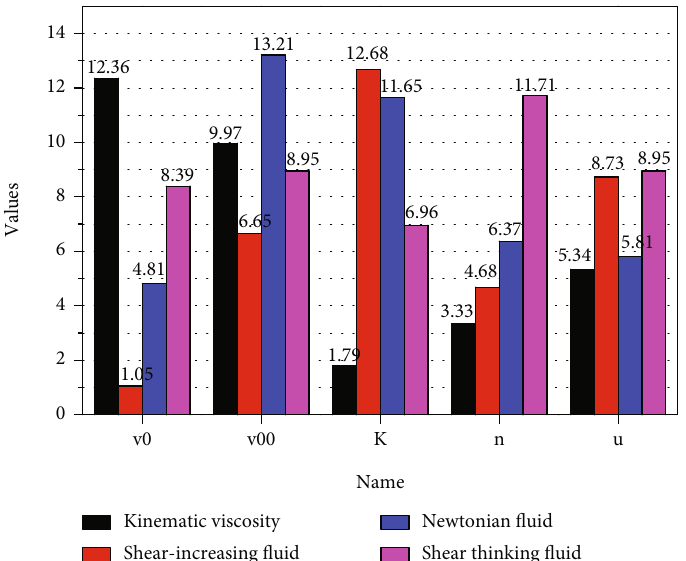
Figure 5: Experimental parameters for non-Newtonian fl uids.